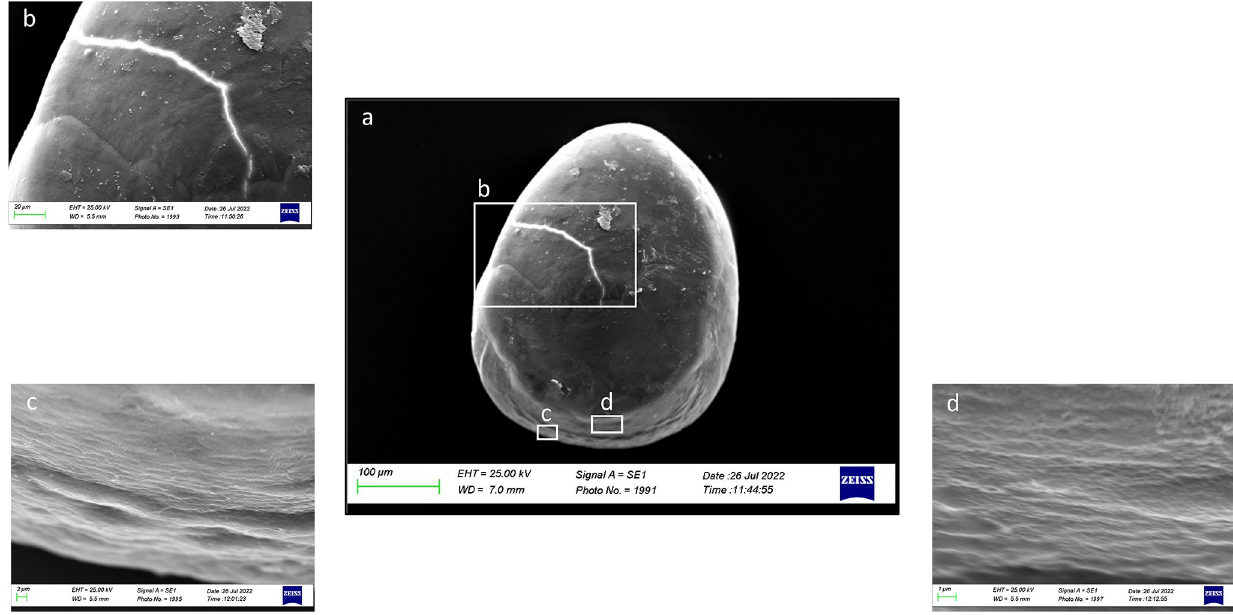
Fig 11. SEM images of a right sagitta inner surface belonging to size Class I (a) with details of the external textural organization of sulcus acusticus (b) and concentric deposition planes of carbonate detected in ventral margin (c and d).